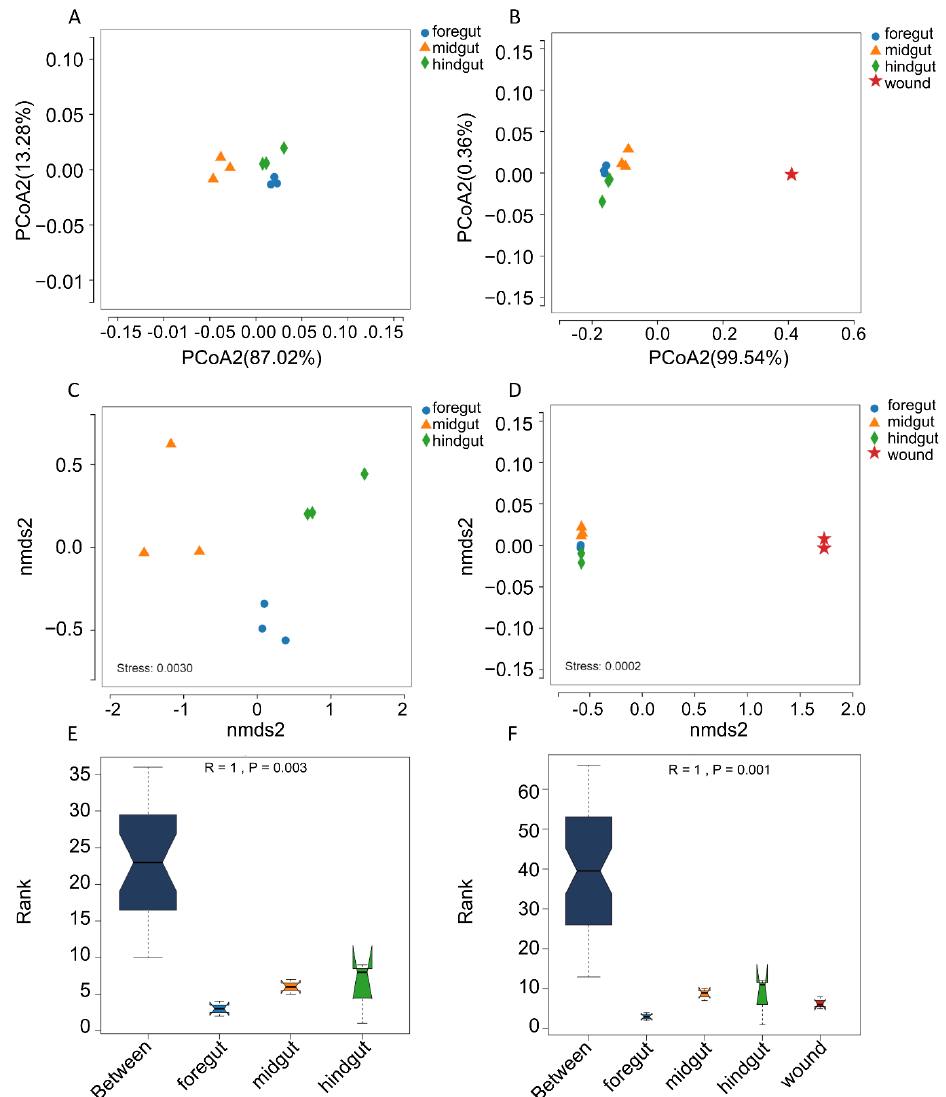
Figure 3. Principal coordinate analysis based on weighted UniFrac distances ( A , B ), nonmetric multidimensional scaling analysis ( C , D ) on the basis of the Bray–Curtis distance matrix, and analysis of similarities (ANOSIM) ( E , F ) of the microbiome from the GI tract ( A , C , E ) and wounds ( B , D , F ) of an Indo-Pacific finless porpoise.